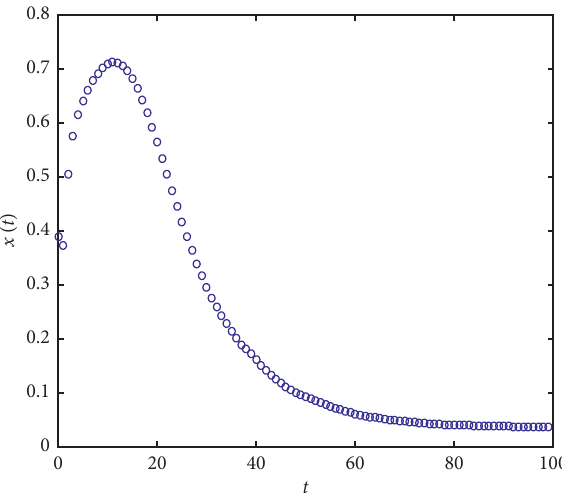
Figure 3: Evolution of average collective opinions (I).